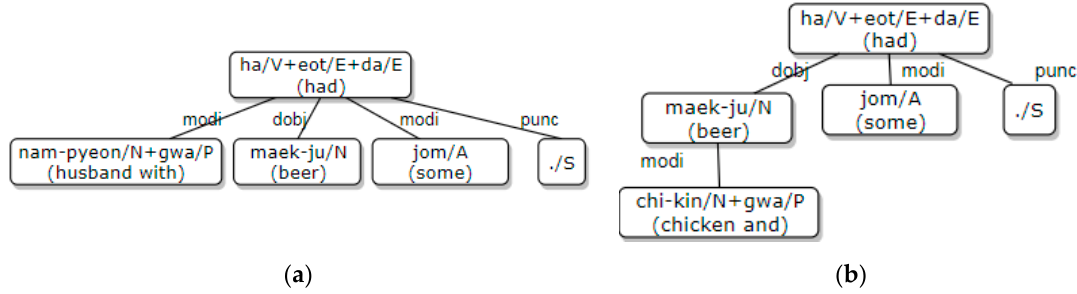
Figure 2. Syntactic ambiguity with “-gwa (with/and): ( a ) Dependency structure of the above first example; ( b ) Dependency structure of the above second example.